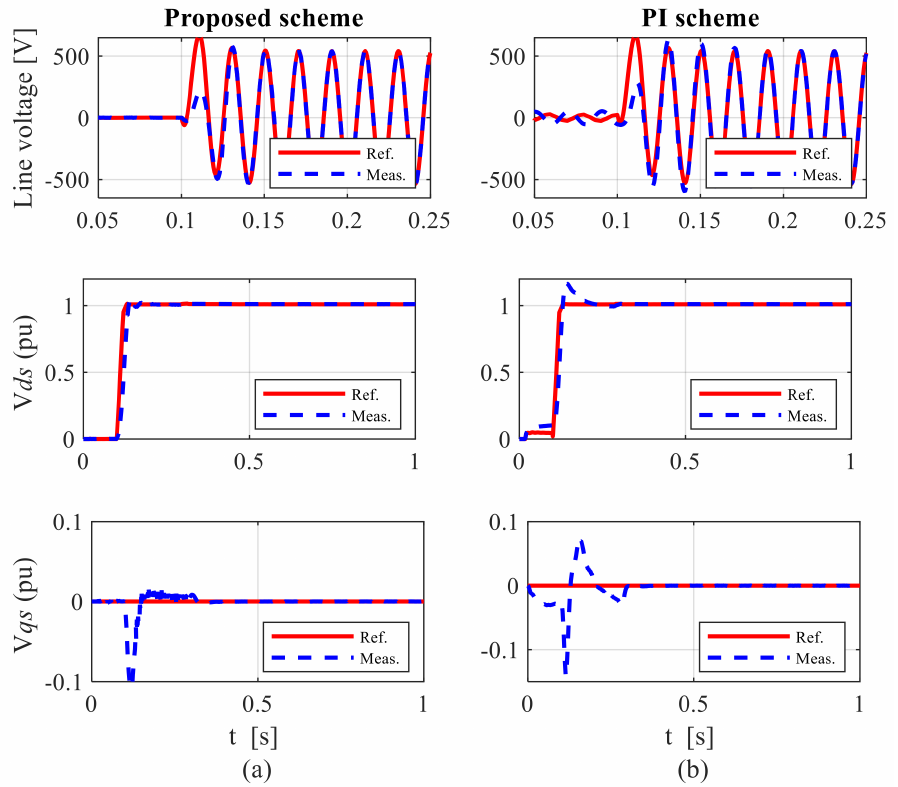
Figure 3. Control performances during sub-synchronous speed operation under balanced grid conditions: ( a ) proposed scheme and ( b ) PI